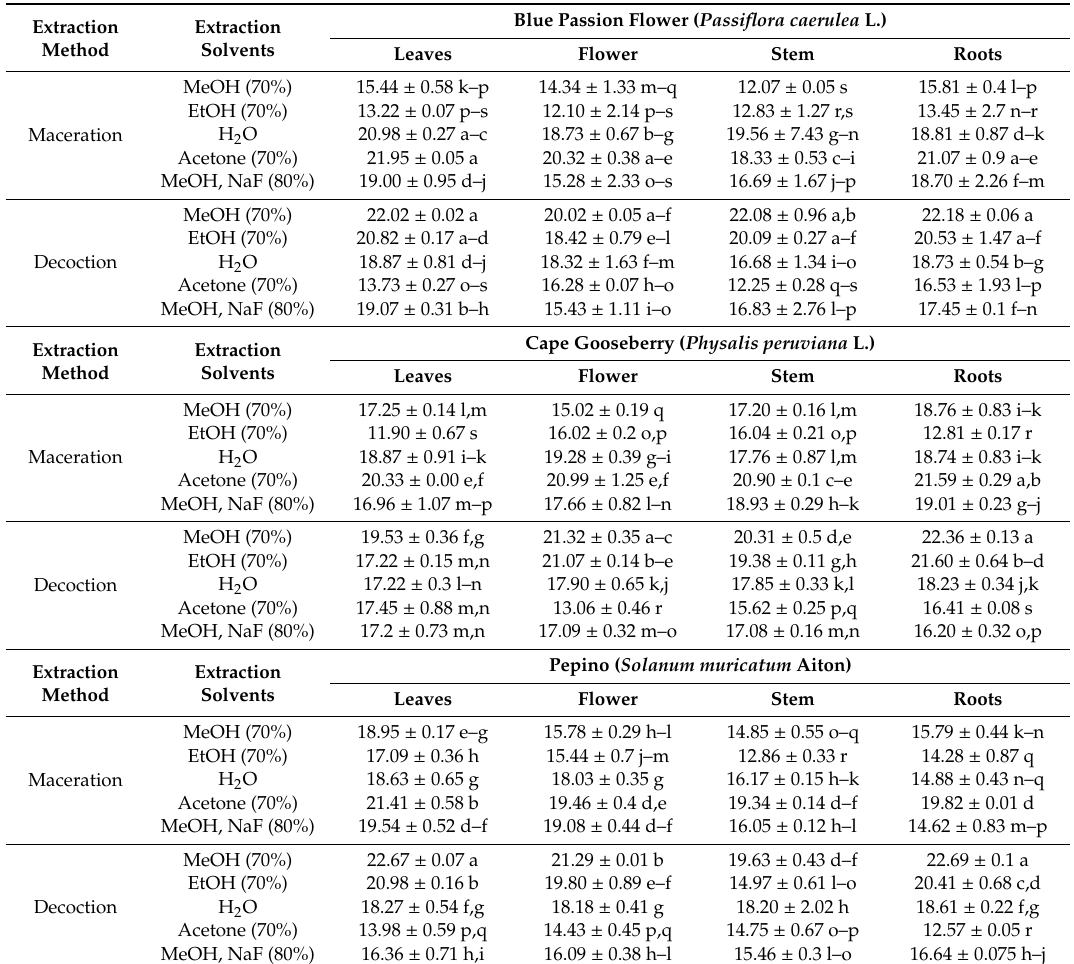
Table 1. Extraction yield (% DM) of the di ff erent parts of blue passion flower ( Passiflora caerulea L.), cape gooseberry ( Physalis peruviana L.) and pepino ( Solanum muricatum Aiton) extracted by decoction and